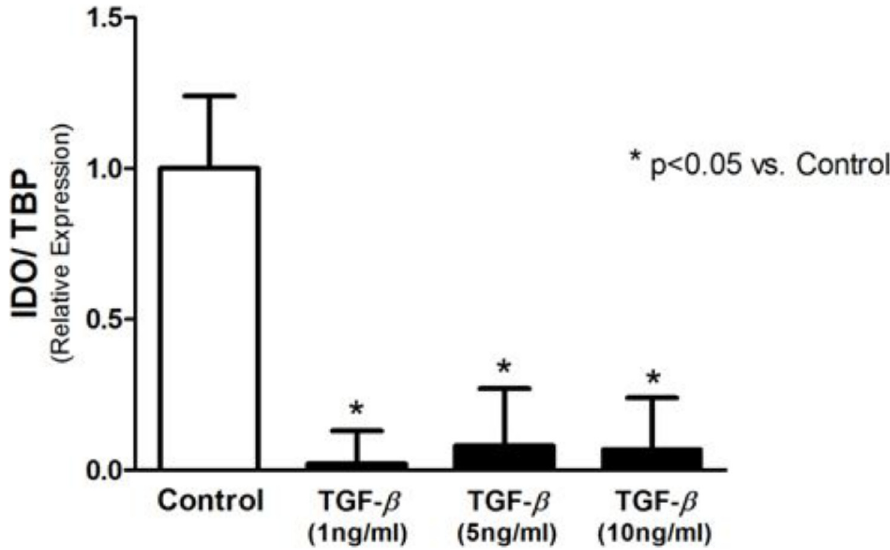
Fig 1. IDO expression analyzed by real-time PCR. IDO expression is downregulated by TGF- β in T24 cells.